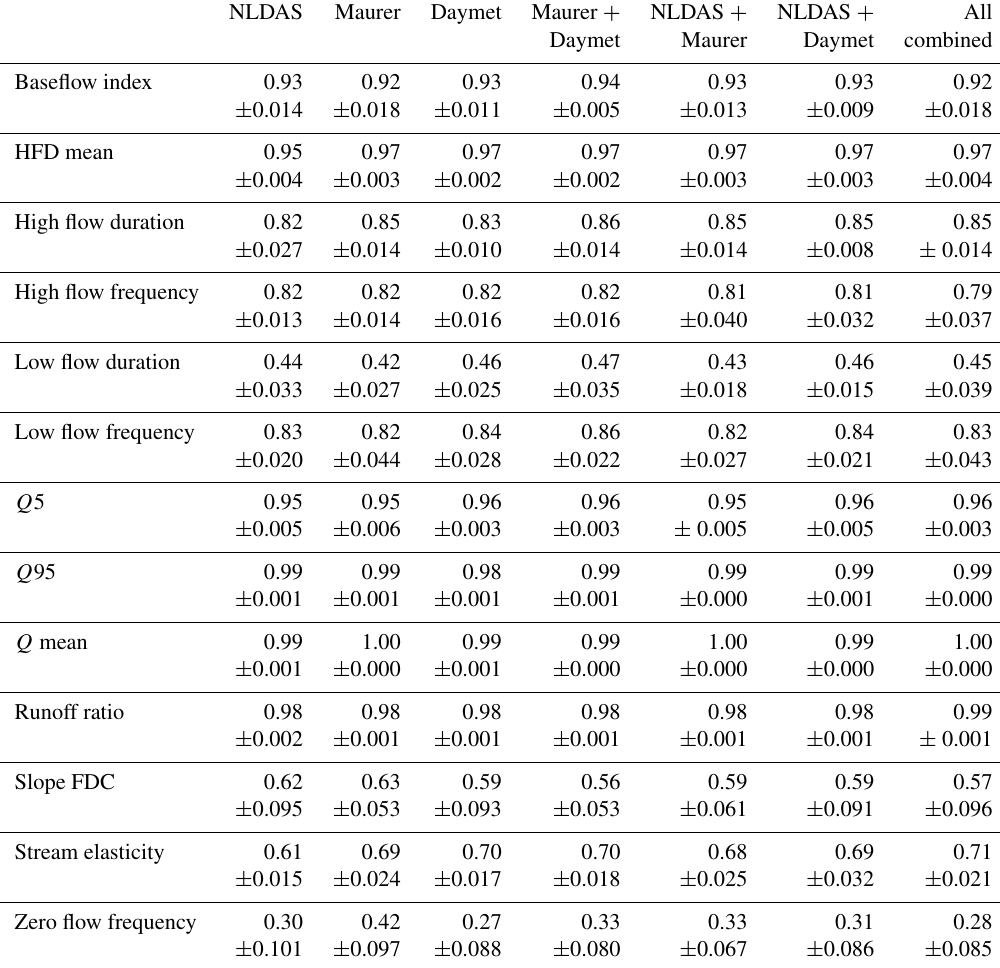
Table A2. Average single LSTM performance across a range of different hydrological signatures. The derived metric for each signature is the Pearson correlation between the signature derived from the observed discharge vs. the signature derived from the simulated discharge. The average single-model performances are then reported as the mean value of the n = 10 model